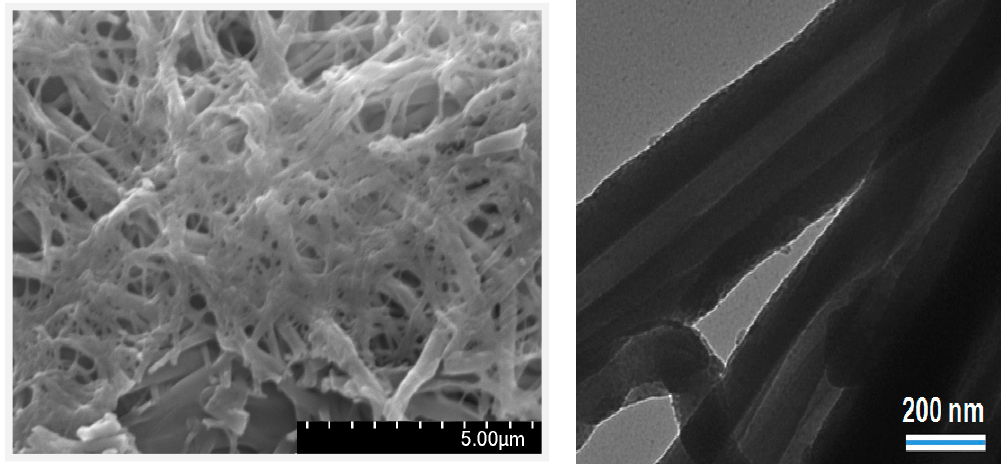
Figure 1. Scanning electron microscopy (SEM) ( left ) and transmission electron microscopy (TEM) ( right ) images of PP-3 tubes (Scale 200 nm for TEM).